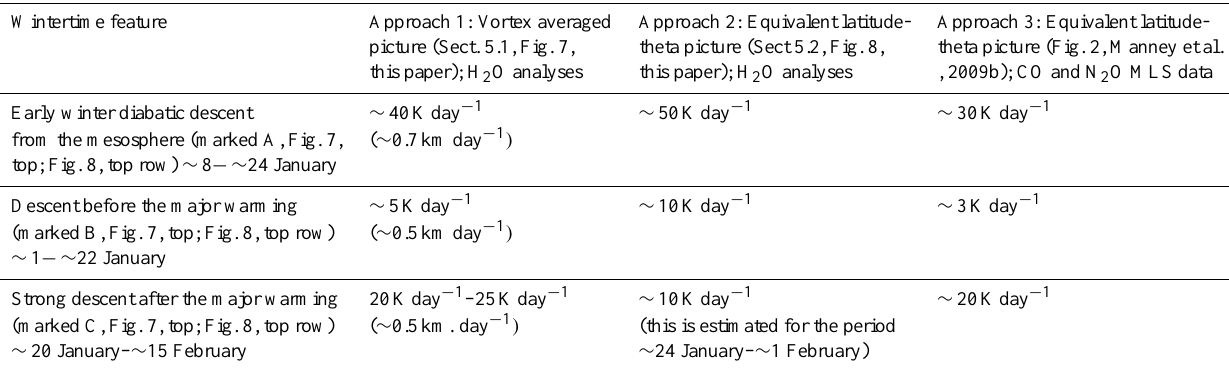
Table 1. Summary of vortex descent rates computed using various approaches. Descent rates are in terms of d (theta)/ dt (unless indicated as kmday − 1 ) .